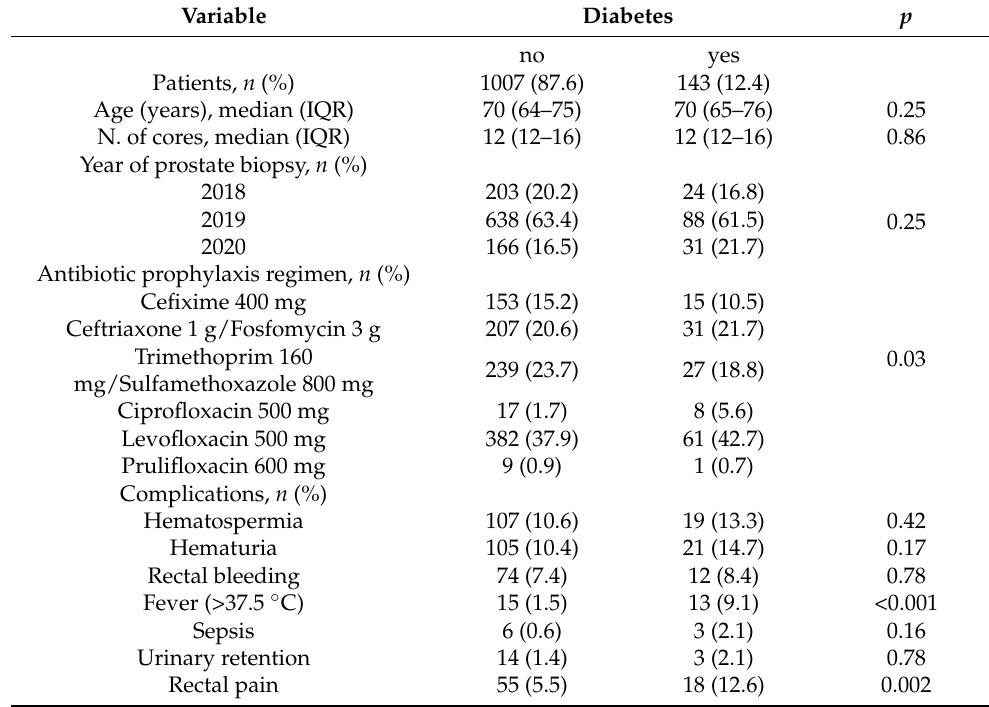
Table 2. Descriptive baseline characteristics and clinicopathological features for the cohort of 1150 patients who underwent transrectal ultrasound prostate biopsy, according to diabetes